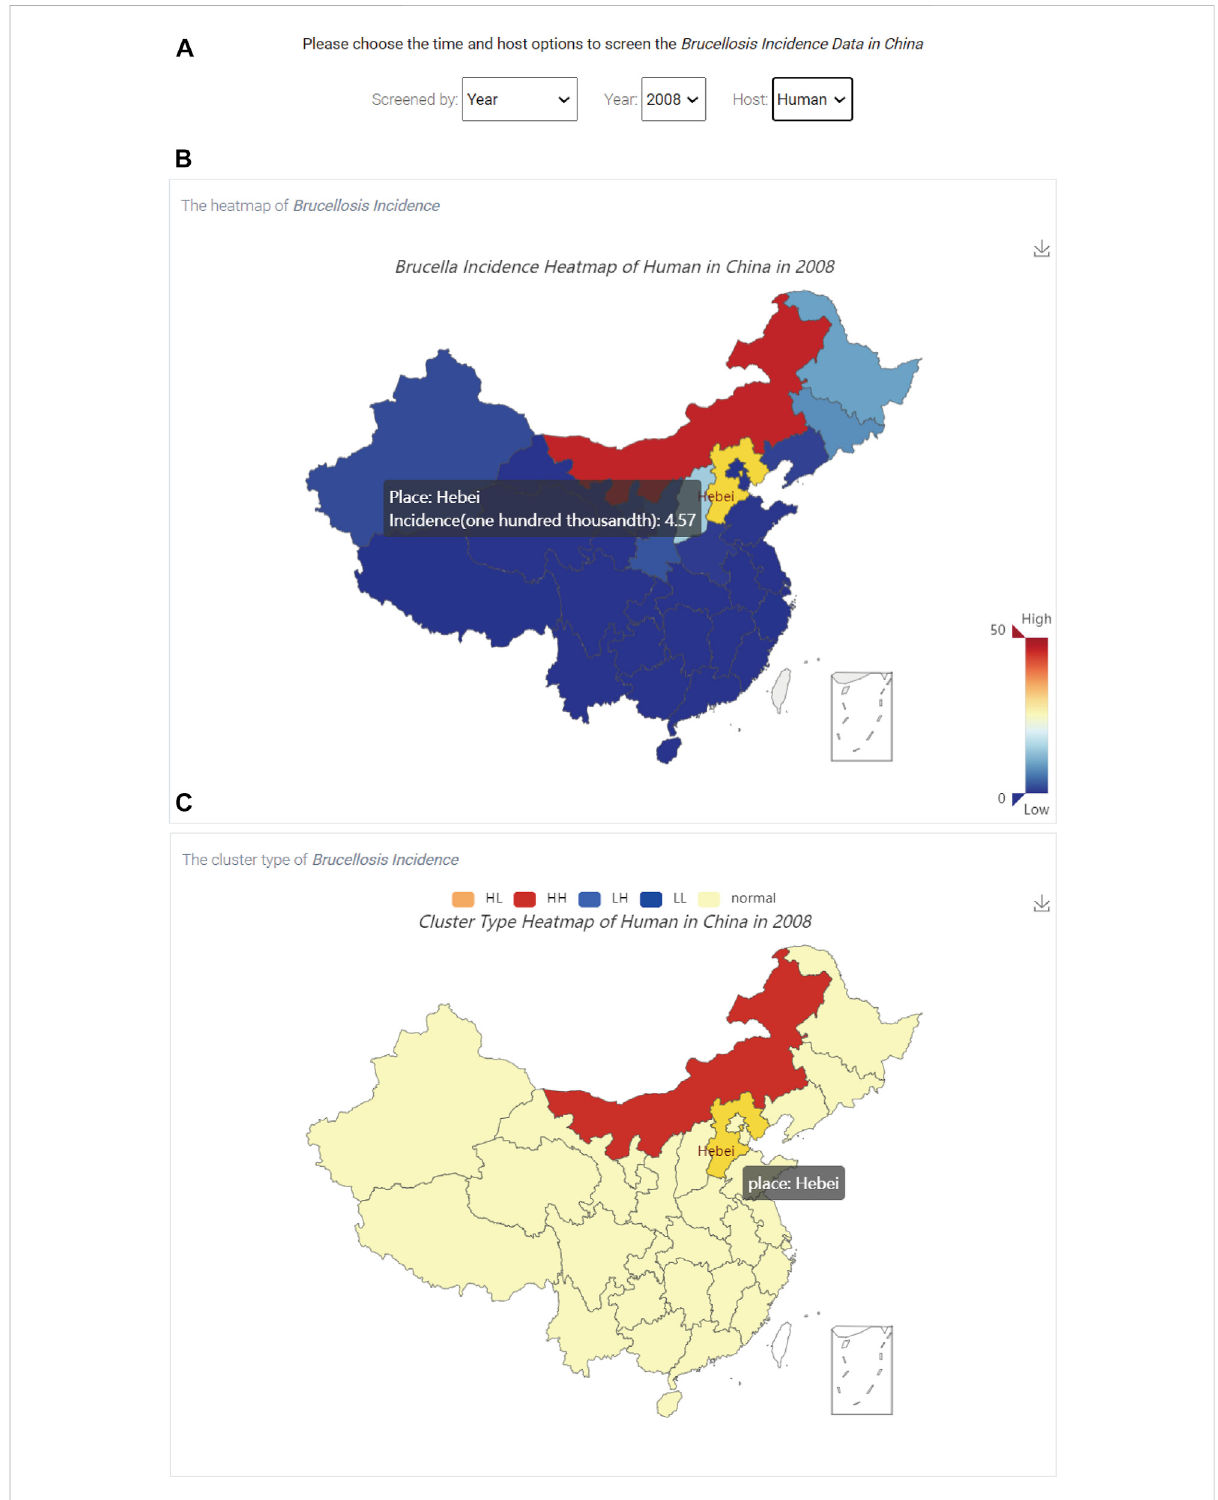
FIGURE 5 The visualization of brucellosis incidence in China. (A) The three option boxes; (B) The spatial distribution of brucellosis incidence; (C) The aggregation of brucellosis